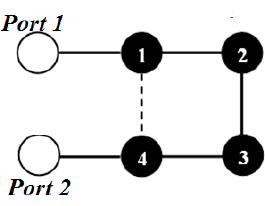
FIGURE 10. Schematic of all resonators (1, 2, 3 and 4) in final step (step four: completion of all stages) .